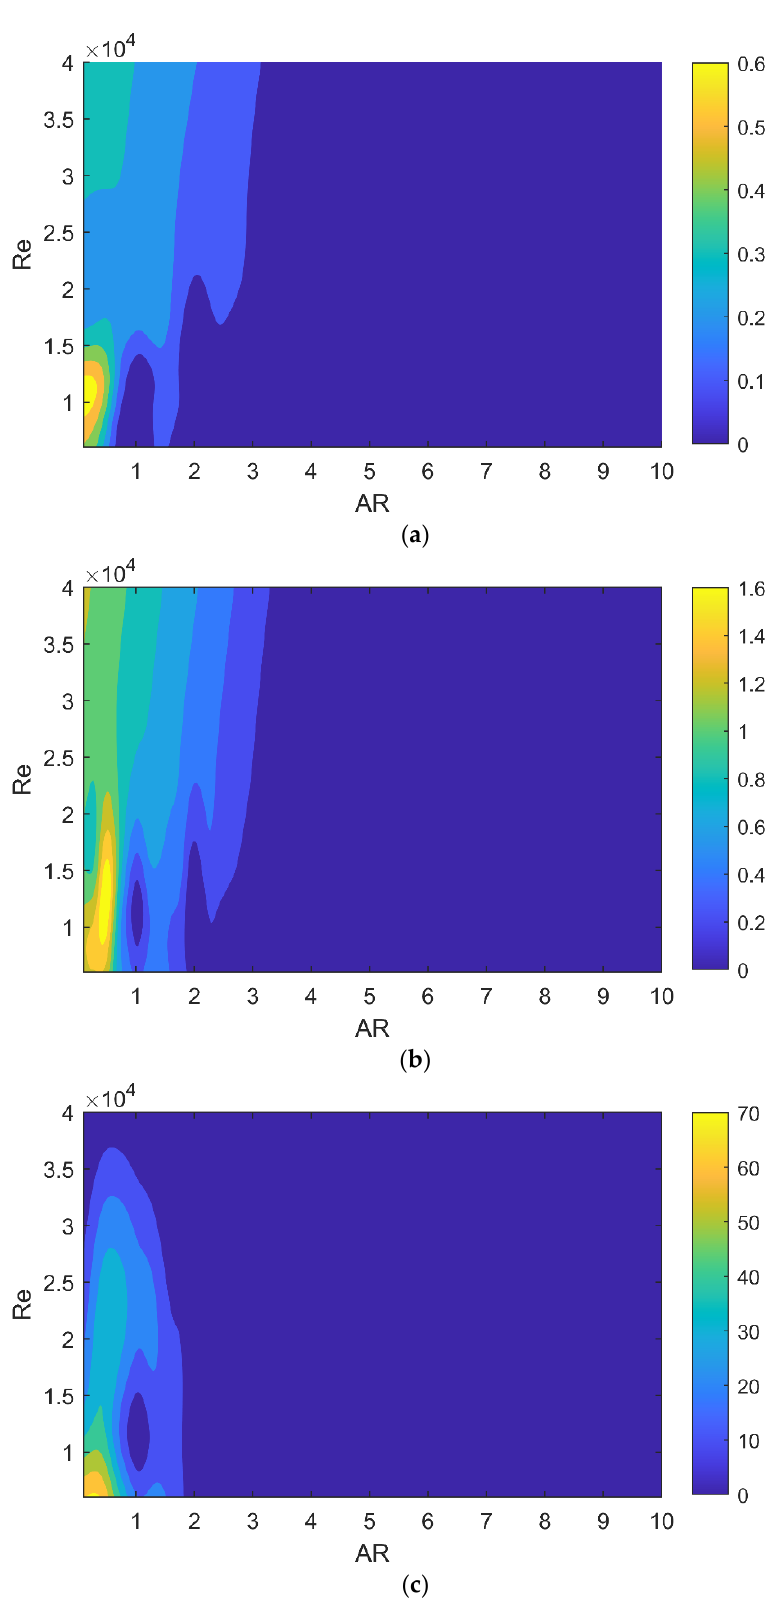
Figure 8. Predictions of unstable zones of hydrodynamic pressure coefficients: ( a ) Drag, ( b ) Lift, and ( c ) Moment coefficients.